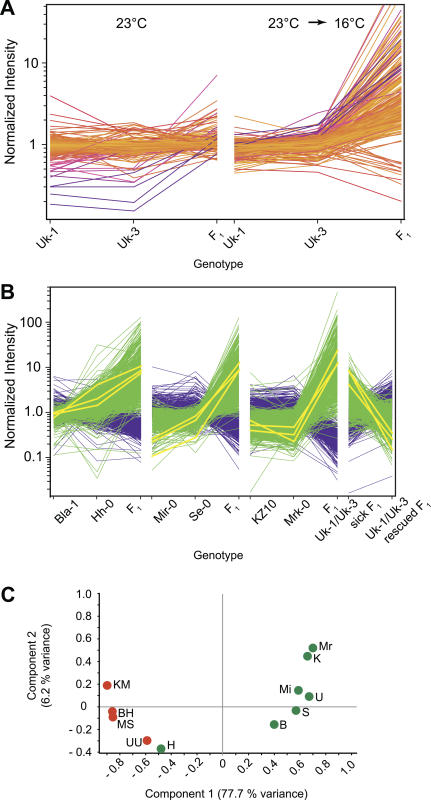
Microarray Analysis of Necrotic Hybrids(A) Expression profiles of Uk-1, Uk-3, and F1 hybrids. Genes shown differ significantly between the F1 and the two parents at 16 °C, but do not differ between the two parents.(B) Profiles of 1,080 genes that are significantly changed in at least one hybrid relative to its parents at 16 °C. Genes induced in hybrids are in green; suppressed genes are in blue. Yellow lines indicate three genes commonly used as markers of pathogen response (PR1, PR2, and PR5; see also Figure S3). In addition to profiles for three hybrids and their parents, regular Uk-1/Uk-3 hybrids (“sick”) are compared with siblings that are phenotypically rescued by a transgene that inactivates DM1.(C) PCA using the same set of 1,080 genes, with hybrids marked red and parents green. B, Bla-1; BH, Bla-1/Hh-0 F1; H, Hh-0; K, KZ10; KM, KZ10/Mrk-0 F1; Mi, Mir-0; Mr, Mrk-0; MS, Mir-0/Se-0 F1; S, Se-0; U, rescued Uk-1/Uk-3 F1; UU, nontransgenic Uk-1/Uk-3 F1.